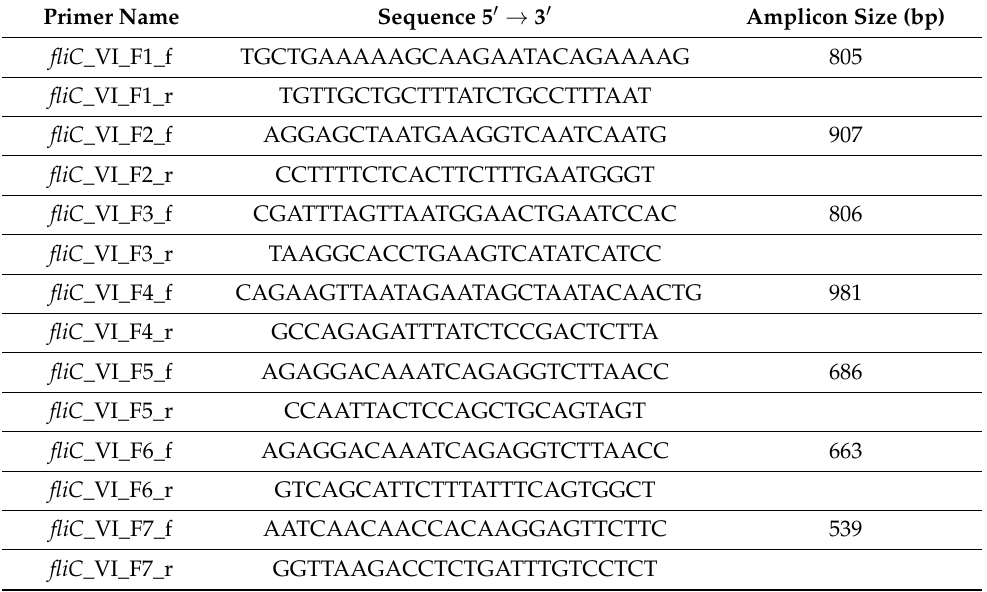
Table 2. Primers for fliC gene